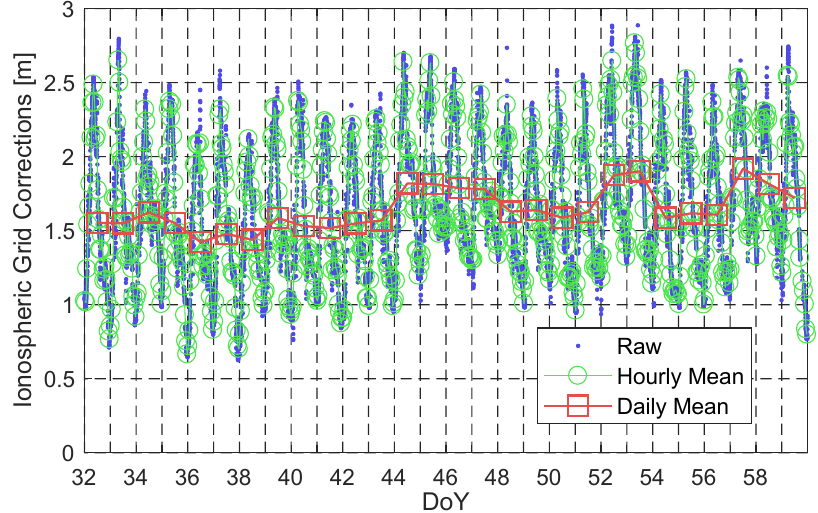
Figure 4. One-month BDS real-time ionospheric grid corrections of IGP 16.